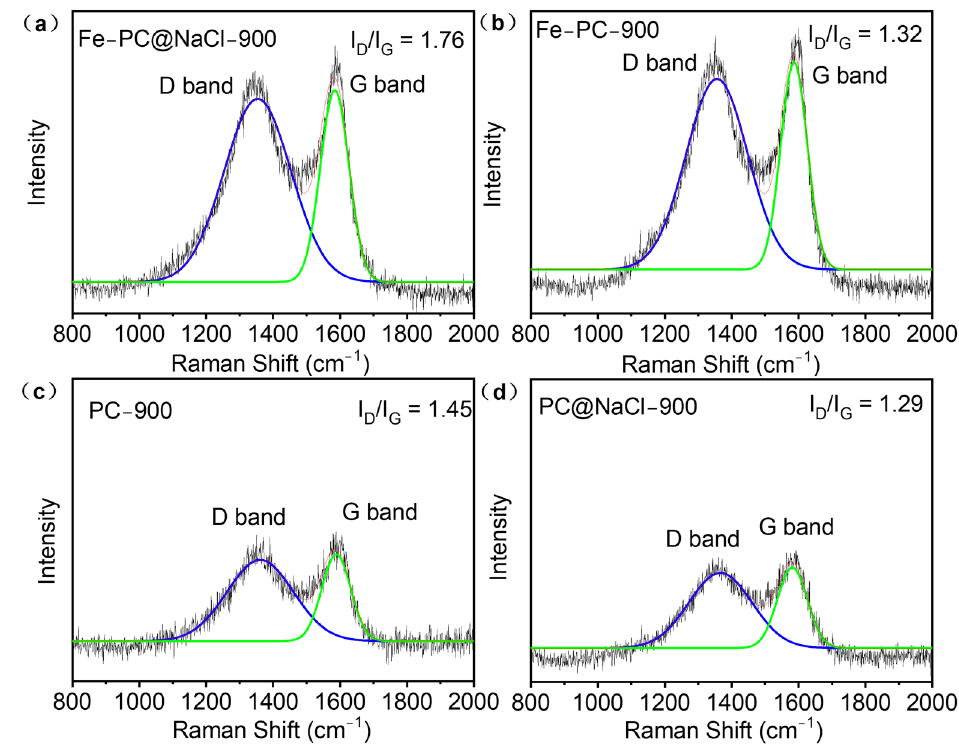
Figure 5. ( a – d ) Raman spectra of PC, Fe-Pc, PC@NaCl, and Fe-PC@NaCl.